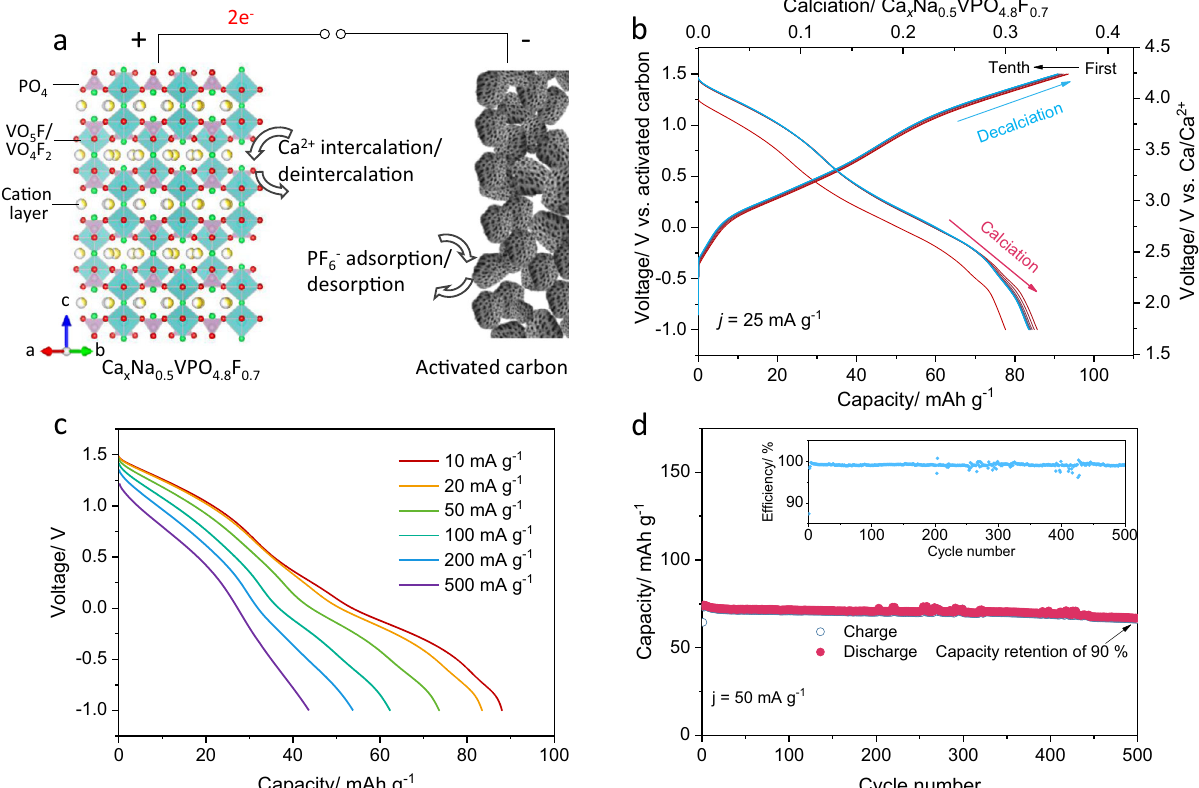
Fig. 1 Electrochemical performance of desodiated NVPF cathode in CIBs. a Schematic illustration of the working principle of a CIB where the insertion/ removal of Ca 2 + ions in Ca x Na 0.5 VPO 4.8 F 0.7 cathode is accompanied with adsorption/desorption of PF 6 − on activated carbon anode. The VO 5 F/VO 4 F 2 octahedra, PO 4 tetrahedra and cation (Na, Ca, and vacancy) units are shown in a . b First ten cycles of discharge/charge pro fi les at a current density of j = 25 mA g − 1 between − 1 and 1.5 V. c Calcium insertion capacities at increasing current densities from 10 to 500 mA g − 1 . d Long-term discharge/charge capacities and corresponding Coulombic ef fi ciencies at 50 mA g − 1 for 500